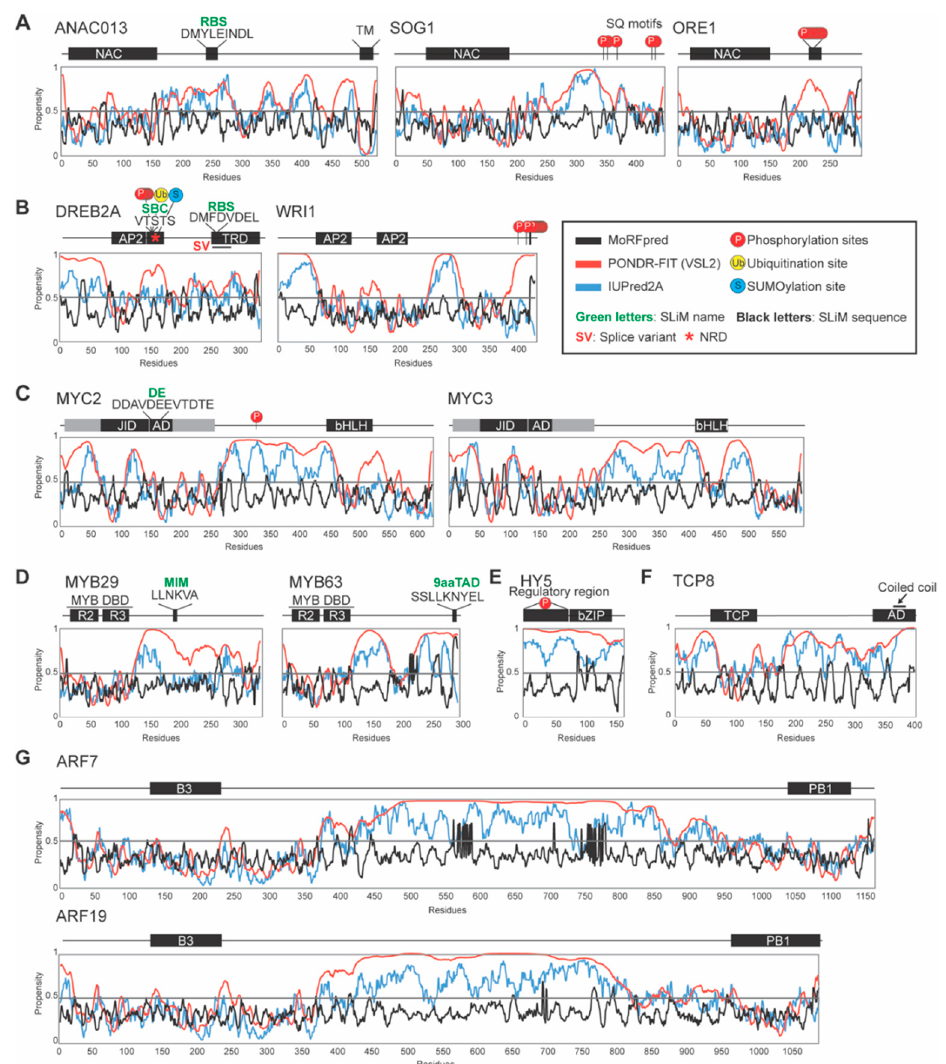
Figure 1. Schematic representations of the domain structures, post translational moodification sites, order-disorder profiles and MoRF profiles of plant TFs with known ID-based functions. The TF shown are from the following TF families: ( A ) NAC; ( B ) AR2 / ERF; ( C ) bHLH; ( D ) MYB; ( E ) bZIP; ( F ) TCP; ( G ) ARF. ID was predicted using IUPred2A (blue line) and PONDR-FIT (VSL2) (red line), and MoRFs were predicted using MoRFpred (black line). The disorder threshold is 0.5 with disorder assigned to values larger than or equal to 0.5.